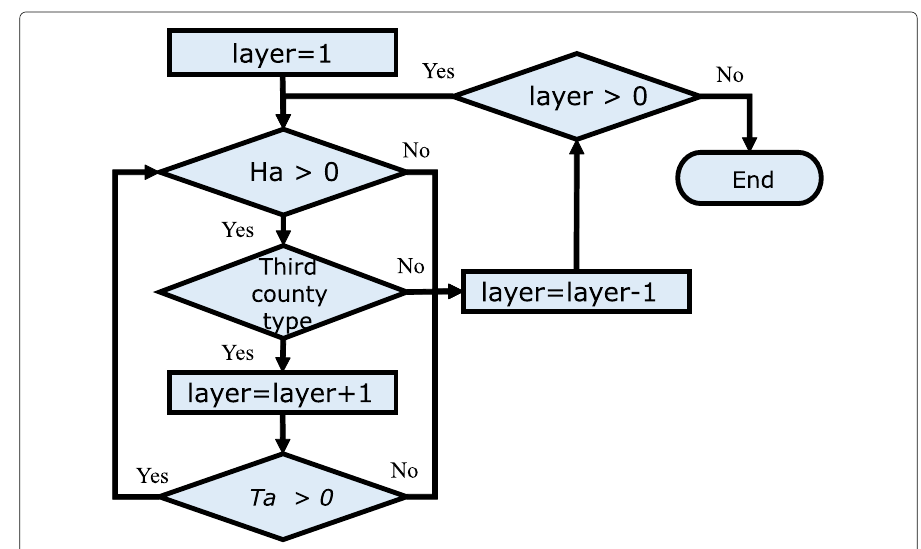
Fig. 3 Flow chart of our model. a indicates a layer. First of all, the “holding” company centrality H a is calculated for affiliates in the first ownership layer. Of it exceeds 0, the “conduit” company centrality T a is calculated for affiliates held by the affiliate with the “holding” company centrality H a exceeding 0